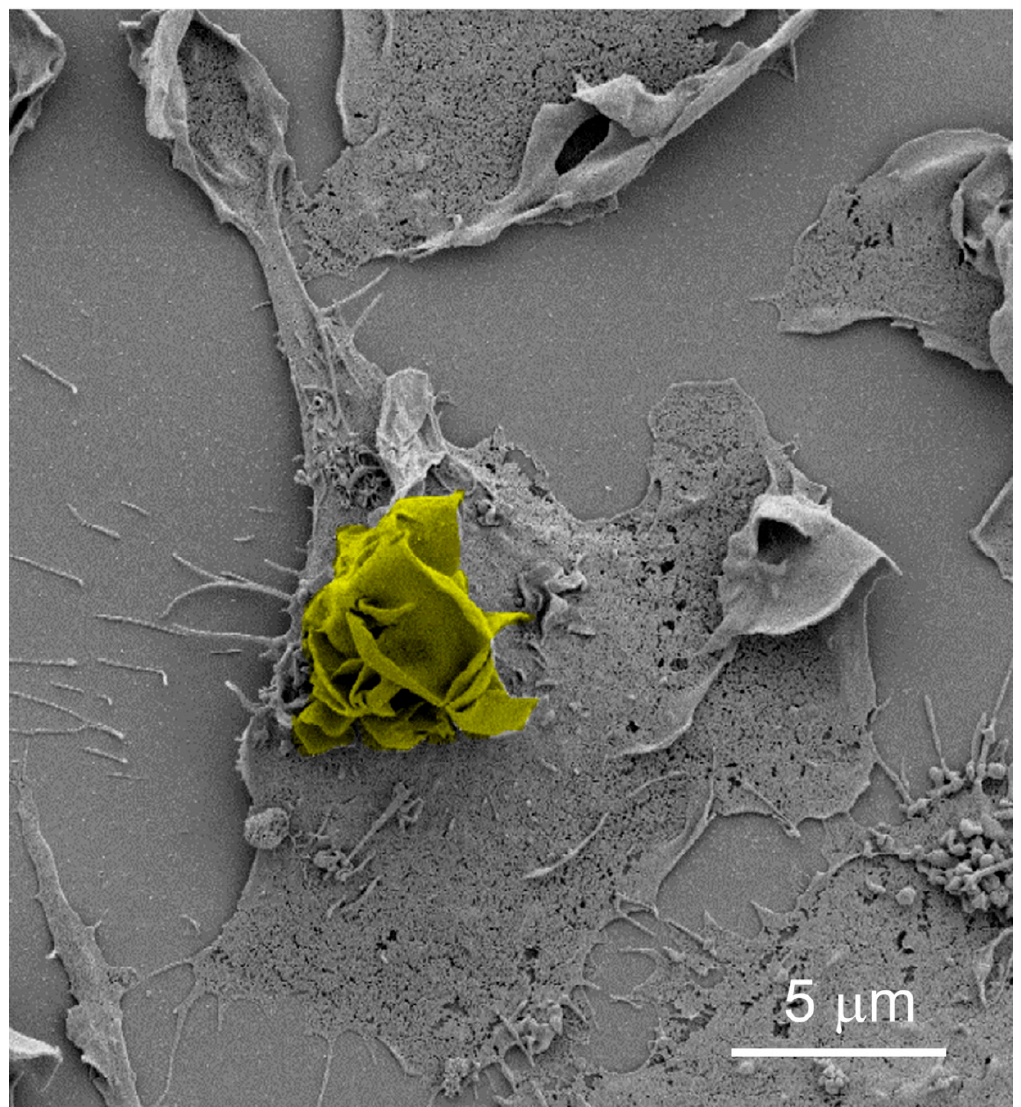
Figure 2. Dorsal ruffles on activated macrophages. Scanning electron micrograph of dorsal plasma Figure 2. Dorsal ru ffl es on activated macrophages. Scanning electron micrograph of dorsal plasma membrane ruffles (pseudocoloured yellow) in CSF-1-activated bone marrow-derived macrophages. membrane ru ffl es (pseudocoloured yellow) in CSF-1-activated bone marrow-derived macrophages. Deficiency of SNX5 results in a dramatic reduction in dorsal ruffling and macropinocytosis. Deficiency of SNX5 results in a dramatic reduction in dorsal ru ffl ing and macropinocytosis. Micrograph Micrograph taken by Dr Prajakta Gosavi from article by Lim et al. [9] (3500× magnification). taken by Dr Prajakta Gosavi from article by Lim et al. [9] (3500 ×